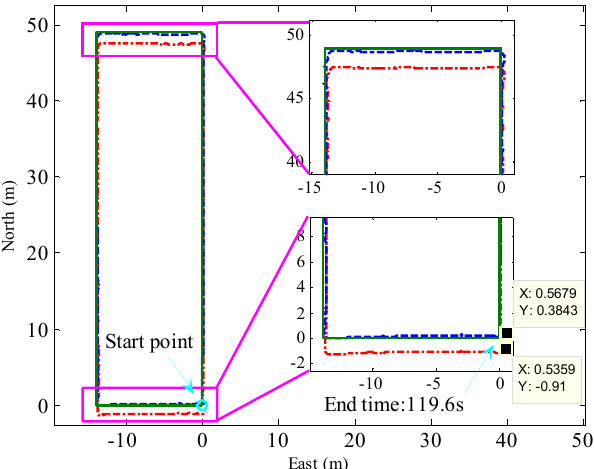
Figure 15. Results of walking along a rectangle trajectory. The red dashed-dotted line and the blue dashed line represent the trajectory calculated by the ZUPT-aided pedestrian navigation algorithm with the traditional fixed threshold method and the adaptive ZVI detection algorithm, respectively. The green solid line is the reference trajectory.